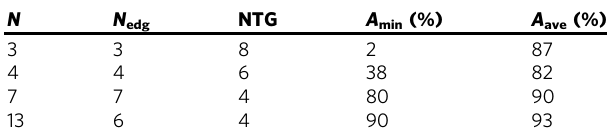
Table. 1 Summary of experimental results. N and N edg stand for number of Ising nodes and number of edges, respectively. NTG stands for number of times that the experiment trapped to the ground state out of 20 times experiment for each case. A min and A ave denote the minimum and average accuracies,